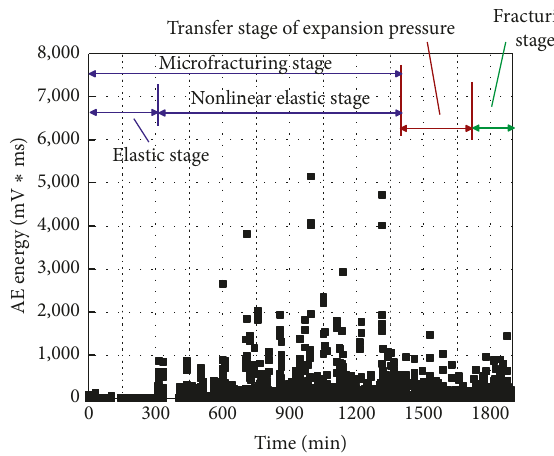
Figure 11: Scatter diagram showing the distribution of the AE energy detected during the static fracturing of the C40 test block.